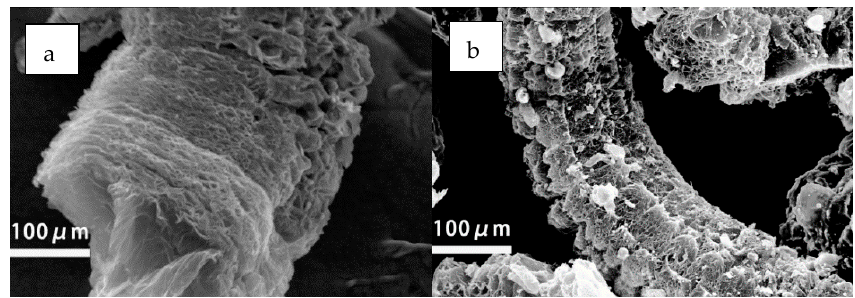
10 of 19 Figure 6. LOI and tensile strength of MPUE/EG at different EG contents . With the incorporation of 5 wt% of EG, the corresponding LOI went down from 22.3% to 20%. Whereas, as the EG content kept increasing, LOI showed an increasing trend. This phenomenon could be explained by the fact that, at low levels of EG content (~5 wt%), the enhanced burning surface dominated, so that LOI declined. However, at high levels of EG content (>10 wt%), expansion-induced flame retardancy dominated so that LOI went up. This was different from the conclusion of a previous study [53], which indicated a strong flame retardant effect of EG on microcellular polyurethane elastomers and rigid porous polyurethane materials. Interestingly, when EG content was 15 wt%, there was no fallen carbon residue throughout the burning process. However, higher or lower EG content led to the ap- parent phenomenon of fallen carbon residue. This could be explained as follows. On the one hand, when EG content was low (<15 wt%), the expanded carbon layers were not able to effectively hold the molten droplets. In this case, carbon residue fell off with the molten droplets during the burning process. On the other hand, when EG content was